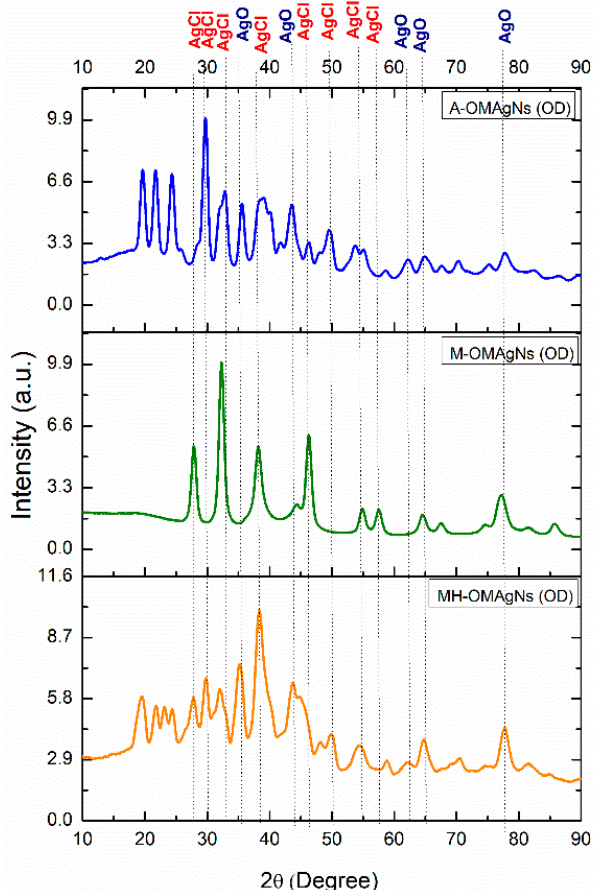
Figure 2. XRD spectra of synthesized OMAgNs.